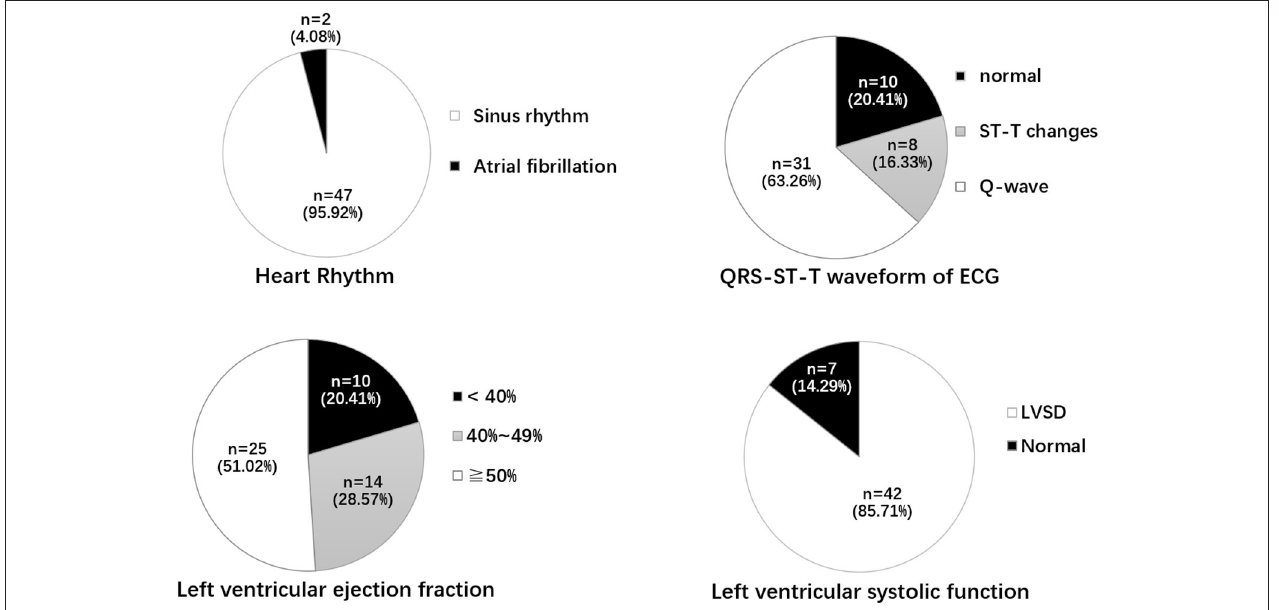
FIGURE 1 | Heart rhythm, QRT-ST-T waveform of ECG, LVEF, and left ventricular systolic function. ECG, electrocardiogram; ST-T change includes depressed ST segment, Low and flat T wave; LVSD, Left ventricular systolic dysfunction; LVEF, left ventricular ejection fraction.